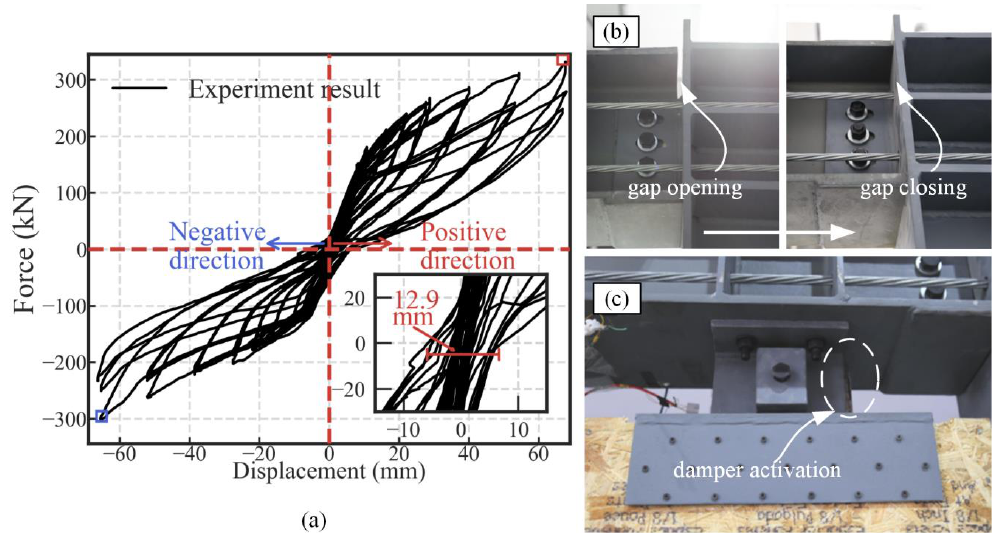
Figure 4. ( a ) Hysteretic response of the SC-STHSW specimen; ( b ) the gap opening and closing in the PT connection; ( c ) the activation of the slip friction damper.